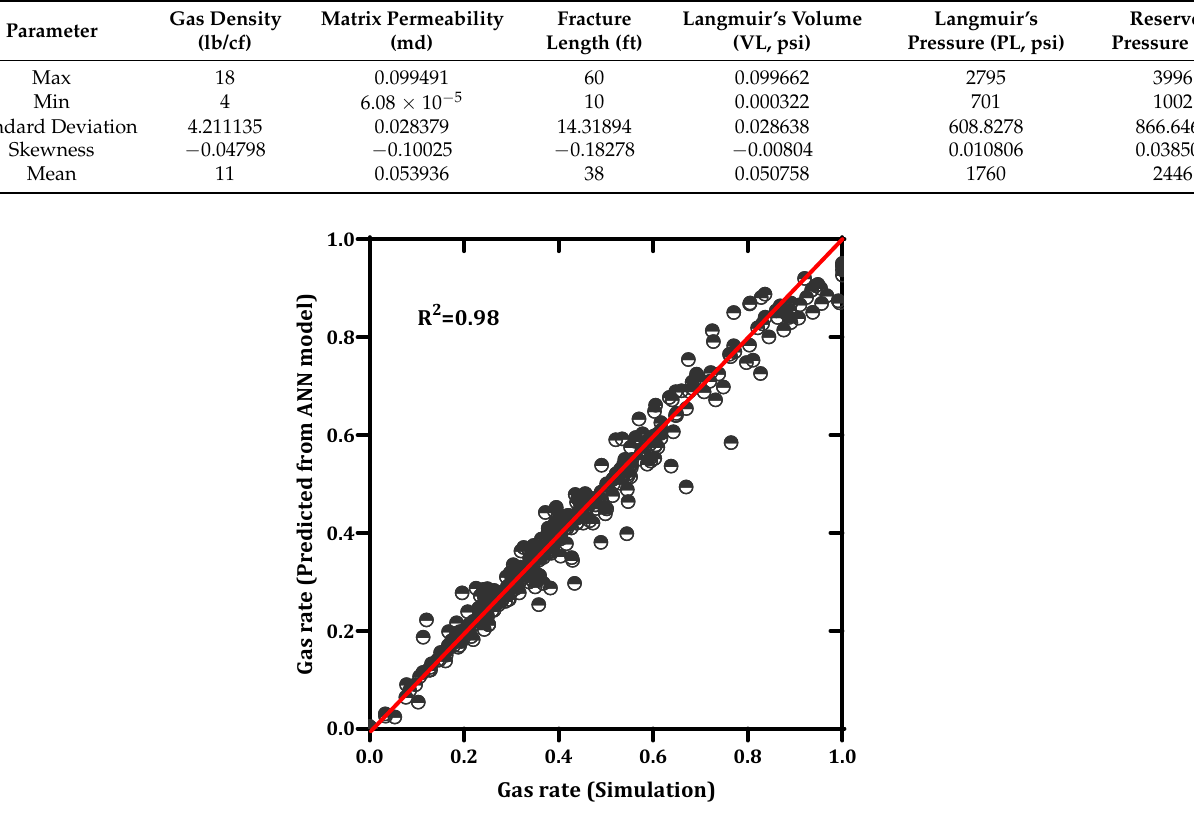
Figure 14. The predicted Qg from ANN versus simulation results for training.